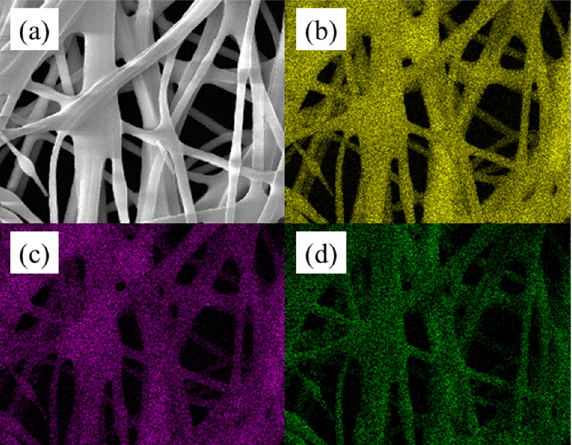
Figure 4. SEM-mapping images of ( a ) Sn 0.7 Ce 0.3 O 2 fibers, ( b ) Sn, ( c ) Ce, and ( d ) O.